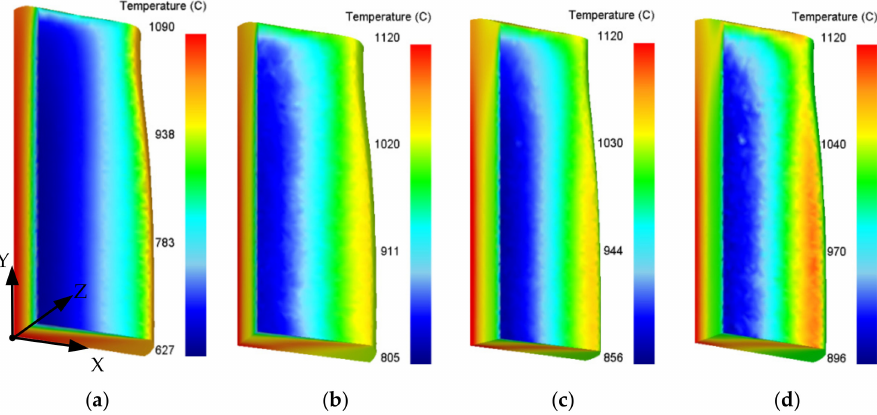
Figure 12. Simulation results of final forging temperature under T = 1020 ◦ C. ( a ) V = 5 mm/s, ( b ) V = 25 mm/s, ( c ) V = 50 mm/s, ( d ) V = 100